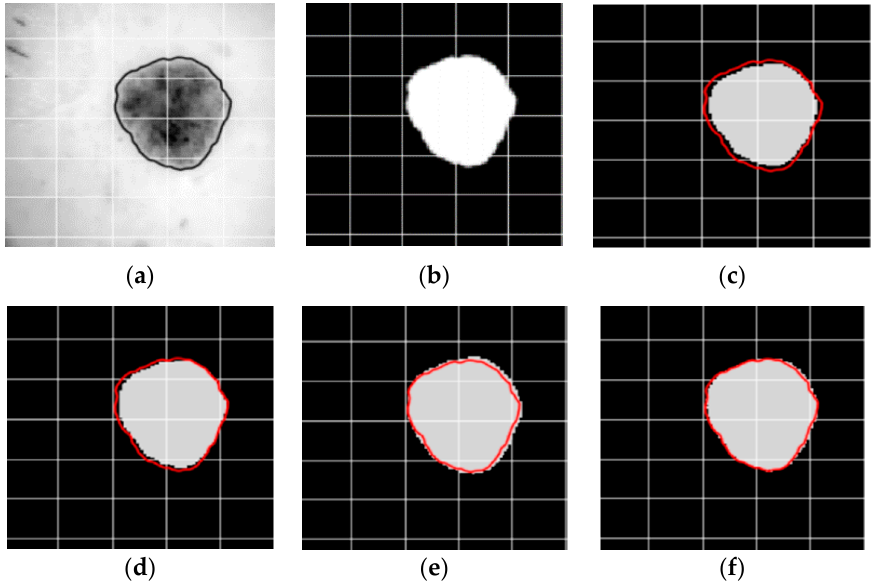
Figure 10. Sample results of segmented skin lesion: ( a ) original image (black line is the ground truth); ( b ) ground truth; ( c ) result of U-Net; ( d ) result of FC€1; ( e ) result of FCN-2; and ( f ) result of proposed model. Notes: 1. White section in the binary image is the segmented skin lesion; 2. Red lines are the ground truth of the input image.